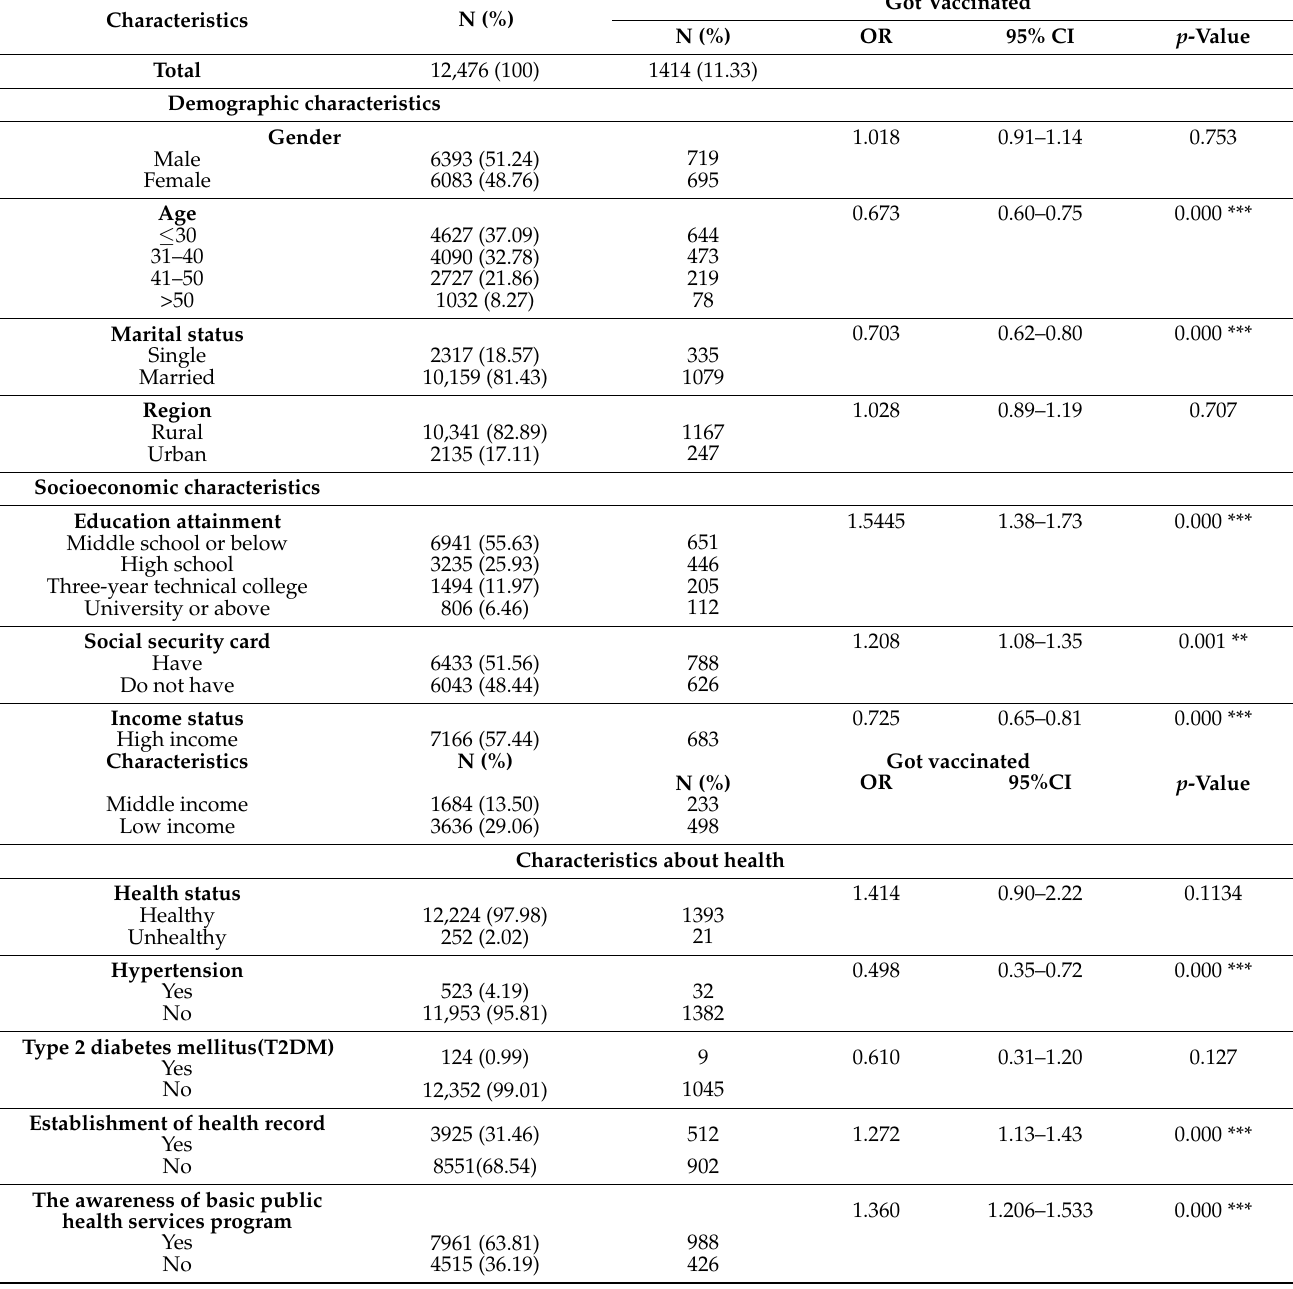
Table 1. Characteristics and influenza vaccination rate of the respondents and univariate analysis at the